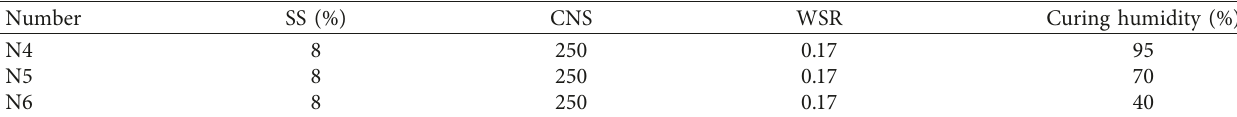
Figure 7: SEM micrographs of CNSCMs with different SS contents and curing time of 28 (d). (a) Copper-nickel slag, (b) 6%, (c) 8%, and (d) 10%. Table 3: Mix proportions of Experiment